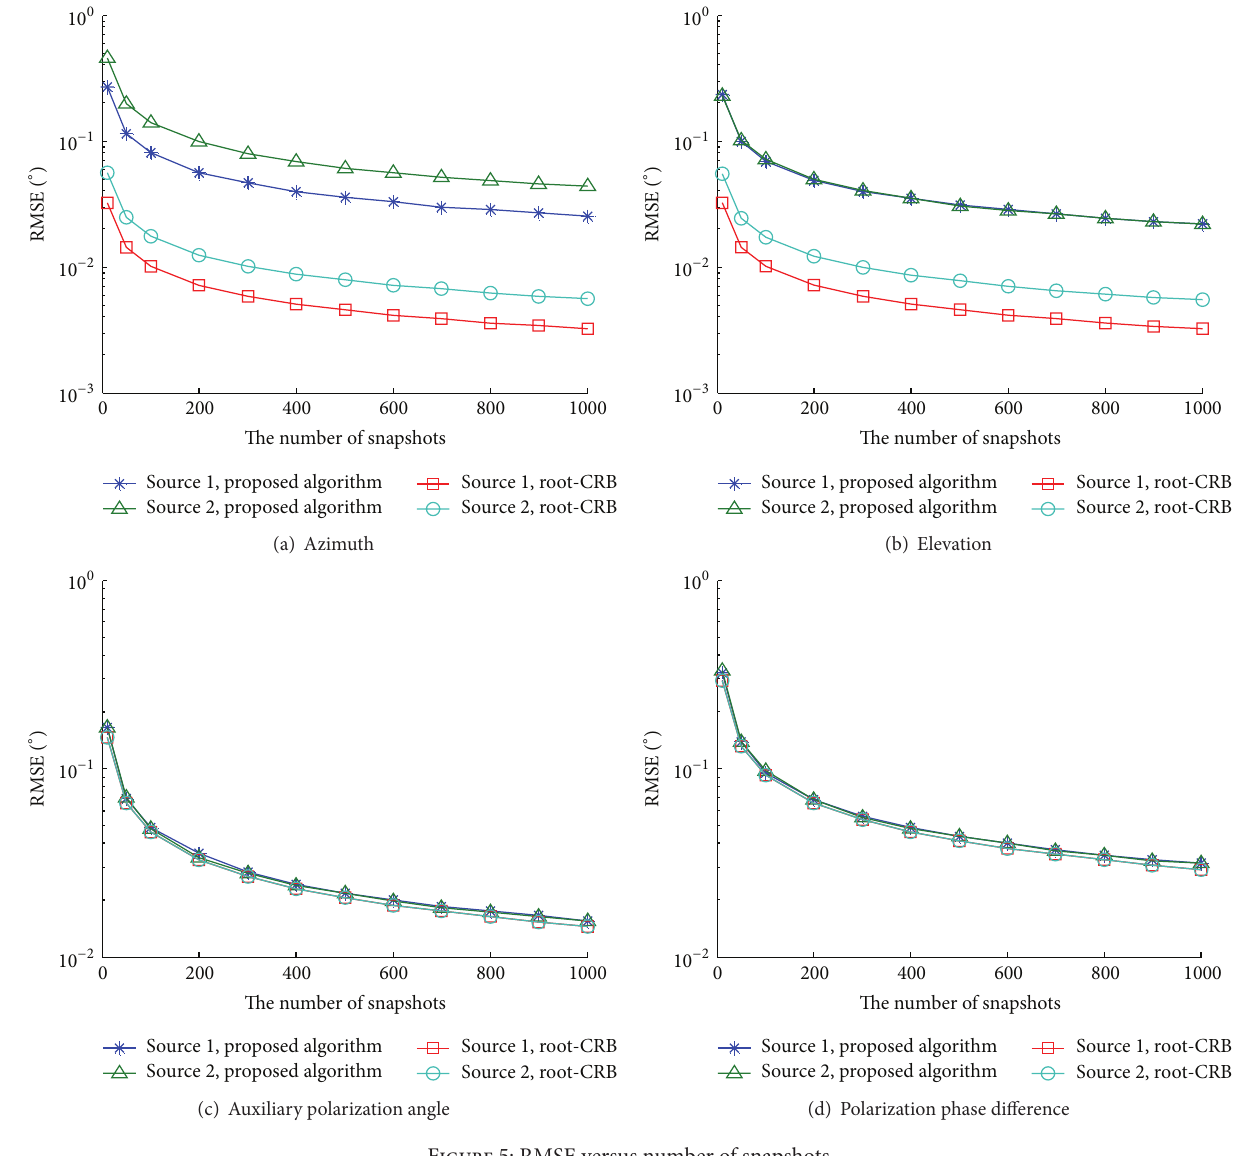
Figure 5: RMSE versus number of